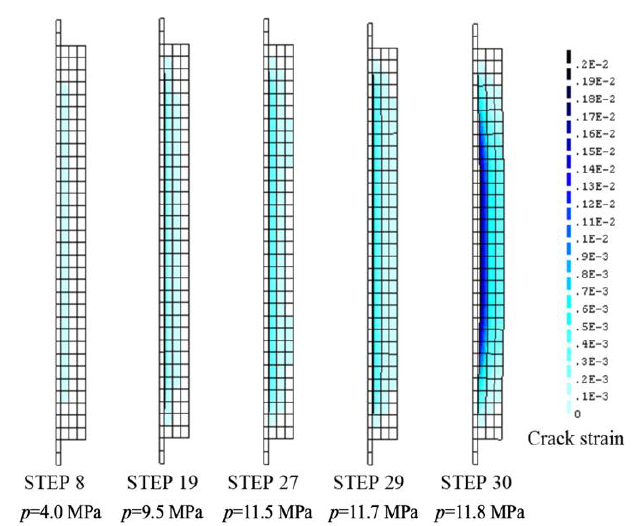
Figure 9. Crack strain contour and deformation properties.